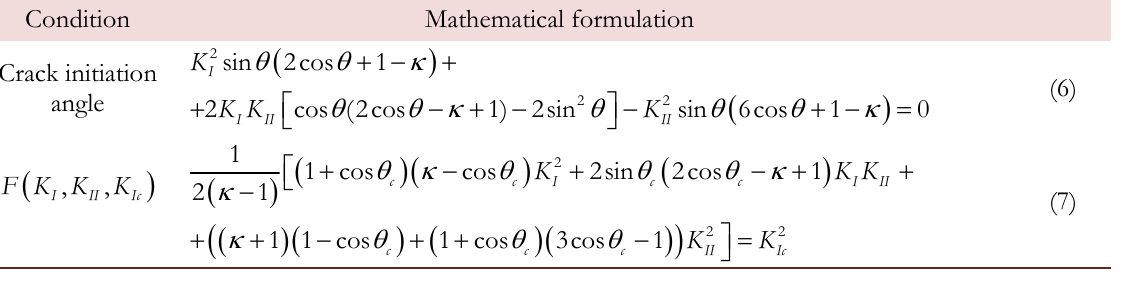
Table 2: The SED criterion.